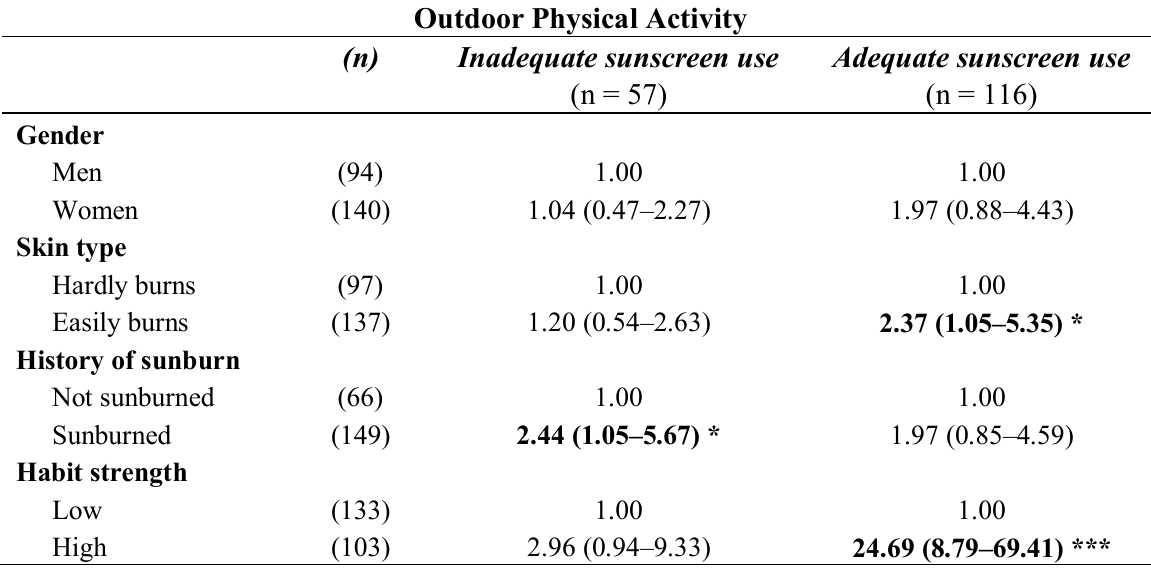
Table 2. Odds ratio (95% CI) of inadequate and adequate sunscreen use compared to no or rare sunscreen use during general outdoor physical